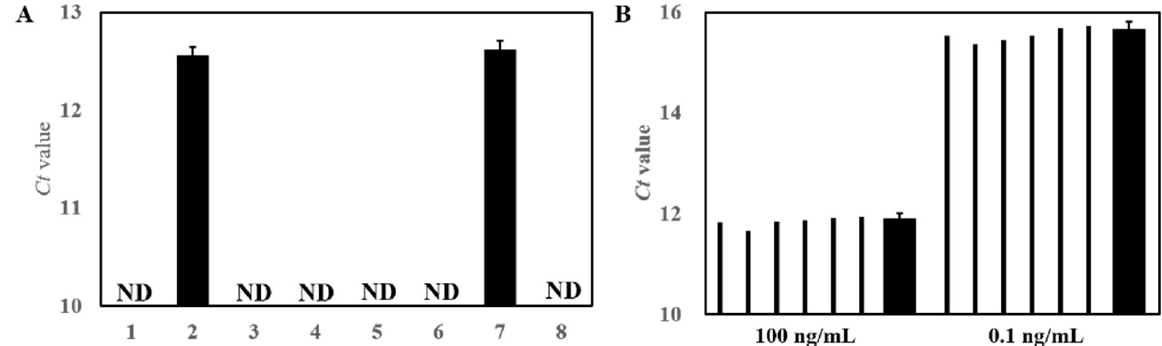
Figure 4. ( A ) The specificity of the proposed aptasensor toward OTA (10 ng mL − 1 ) compared with other mycotoxins (100 ng mL − 1 ). 1: Negative control; 2: OTA; 3: OTB; 4: AFB1; 5: FB1; 6: ZEN; 7: Mixture 1, OTA + OTB + AFB1 + FB1 + ZEN; 8: Mixture 2, OTB + AFB1 + FB1 + ZEN; ND: Not detected. ( B ) Reproducibility of the proposed